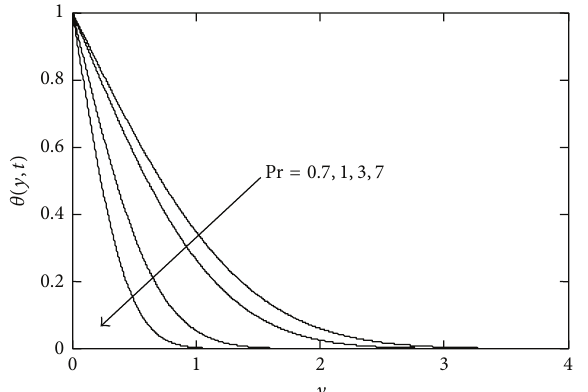
Figure 8: Profiles of temperature for different values of Pr, when 𝑡 = 0.4 .